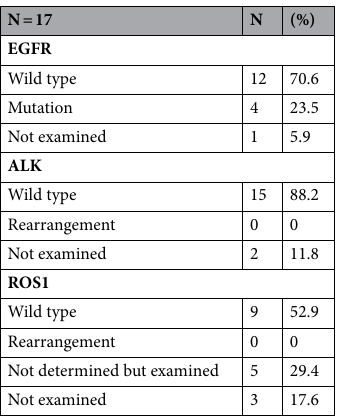
Table 4. Driver mutation status of non-Sq-NSCLC. EGFR mutation, ALK rearrangement, ROS1 rearrangement status of non squamous non-small cell lung cancer was